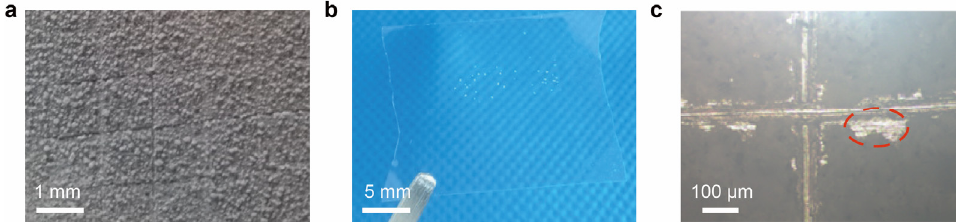
Figure 7. Cross-cut test showed strong adhesion of the F-SiO 2 /MXene superhydrophobic coating. Digital image of ( a ) the coating surface and ( b ) the 3 M tape after the cross-cut test. ( c ) Optical microscope image of the coating surface after the cross-cut test.